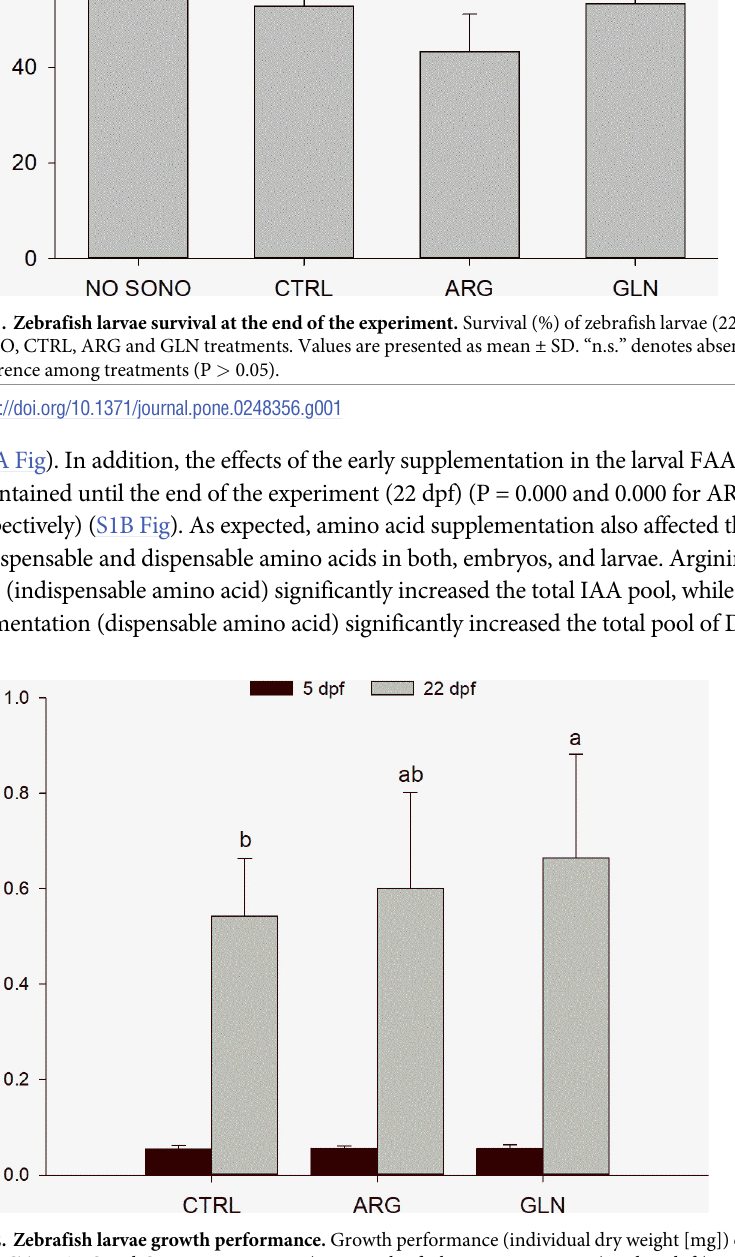
Fig 2. Zebrafish larvae growth performance. Growth performance (individual dry weight [mg]) of zebrafish larvae from CTRL, ARG and GLN treatments at 5 ( n = 3 pools of 6 larvae per treatment) and 22 dpf ( n = 36 individual larvae per treatment) (black and grey bars, respectively). Values are presented as mean ± SD. Different letters denote statistical difference among treatments (P < 0.05).